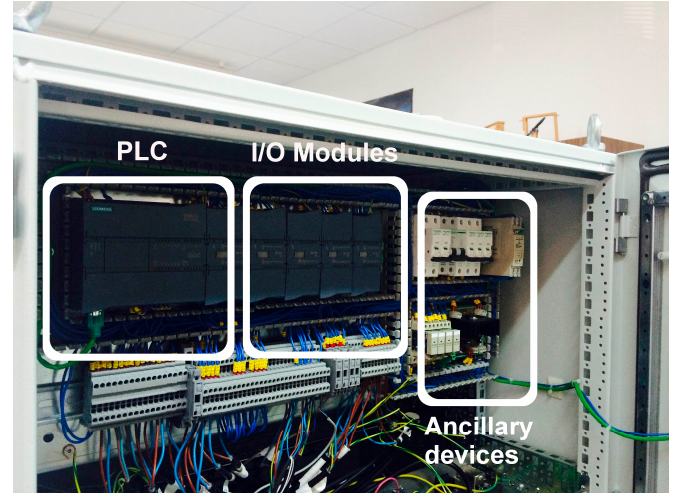
Figure 9. Automation subsystem.